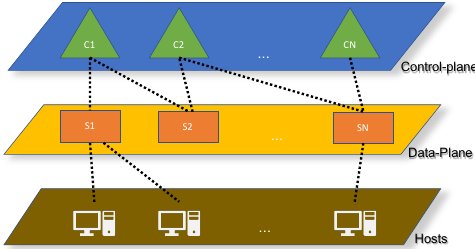
Figure 1. Software-defined network architecture.